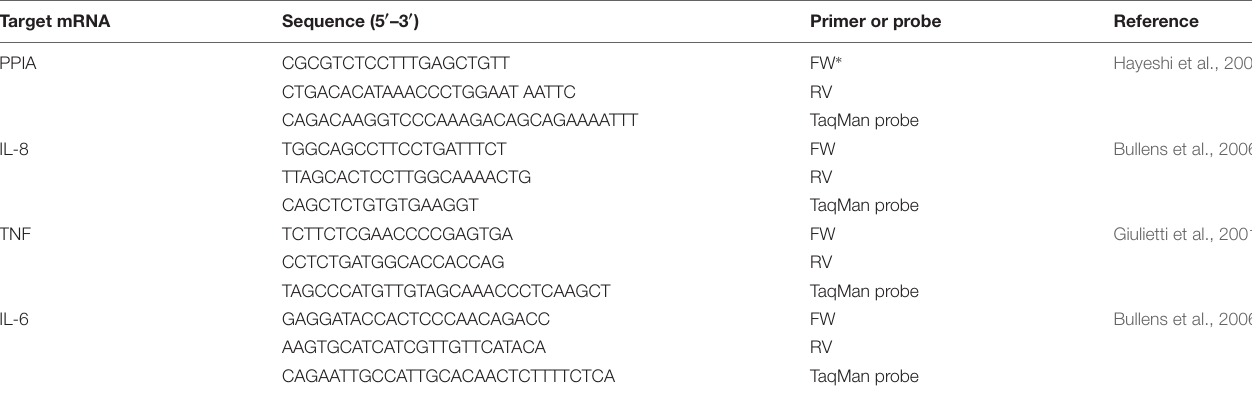
TABLE 1 | Primers and probes used in this study for cytokine mRNA measurements. Target